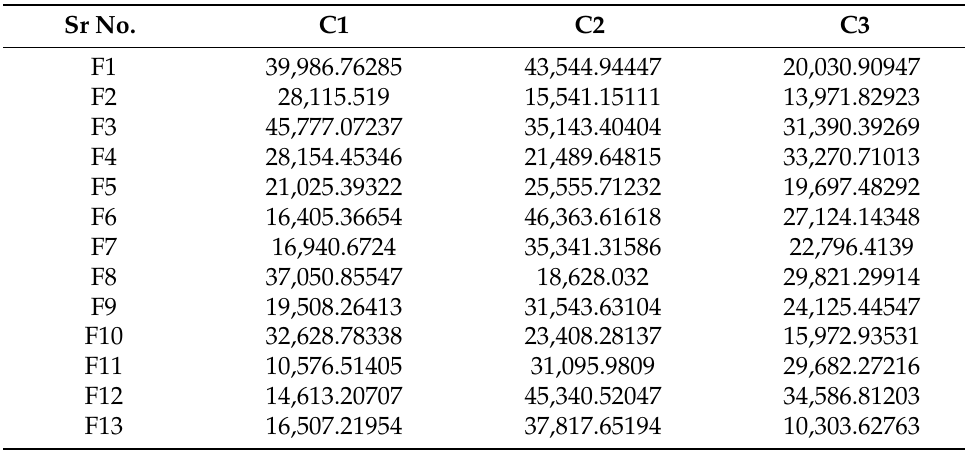
Table 20. The best centroids for Wine obtained by proposed approach.